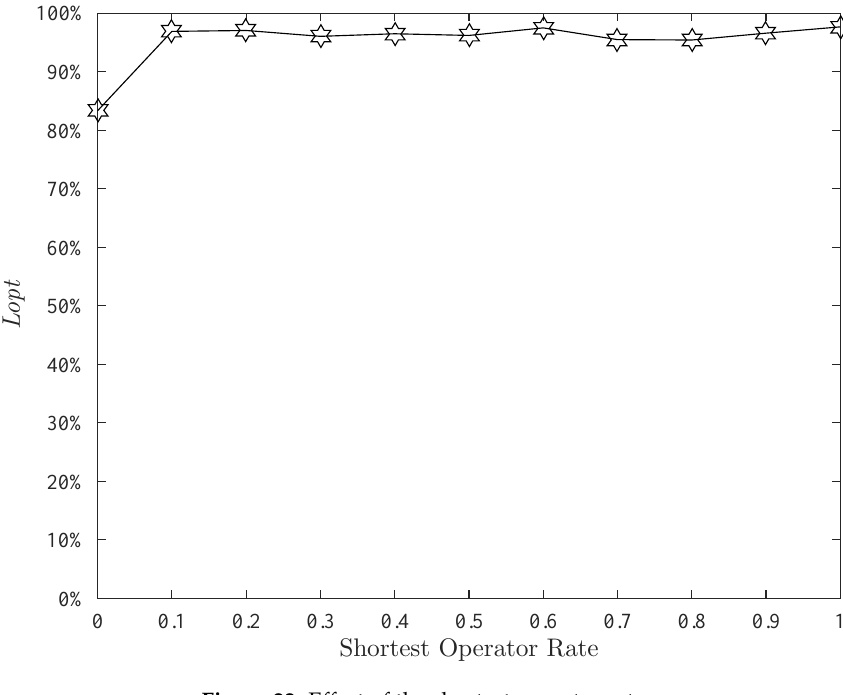
Figure 22. Effect of the shortest operator